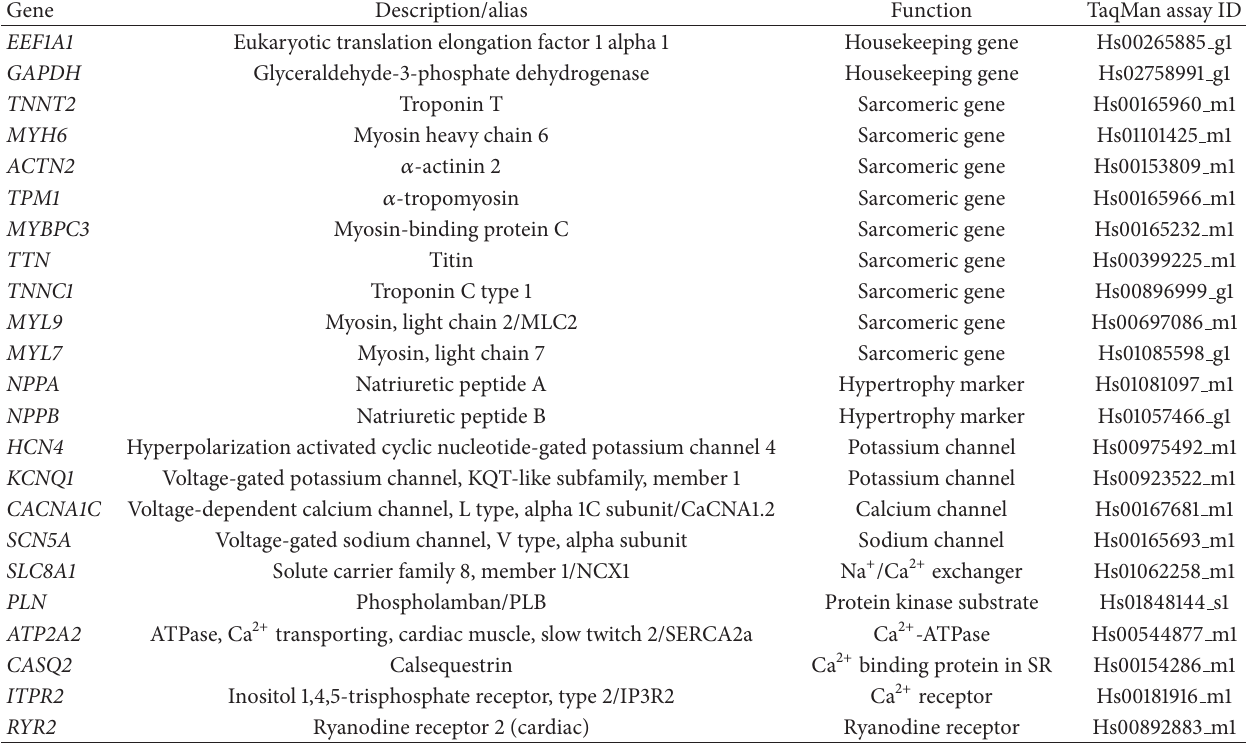
Table 1: TaqMan assays used in qRT-PCR